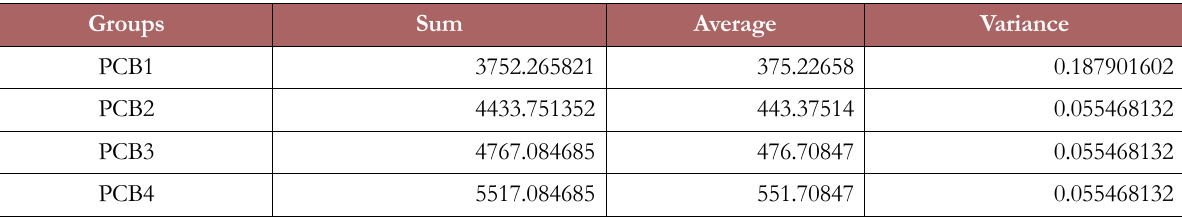
Table 11. ANOVA summary. Printed circuit boards case